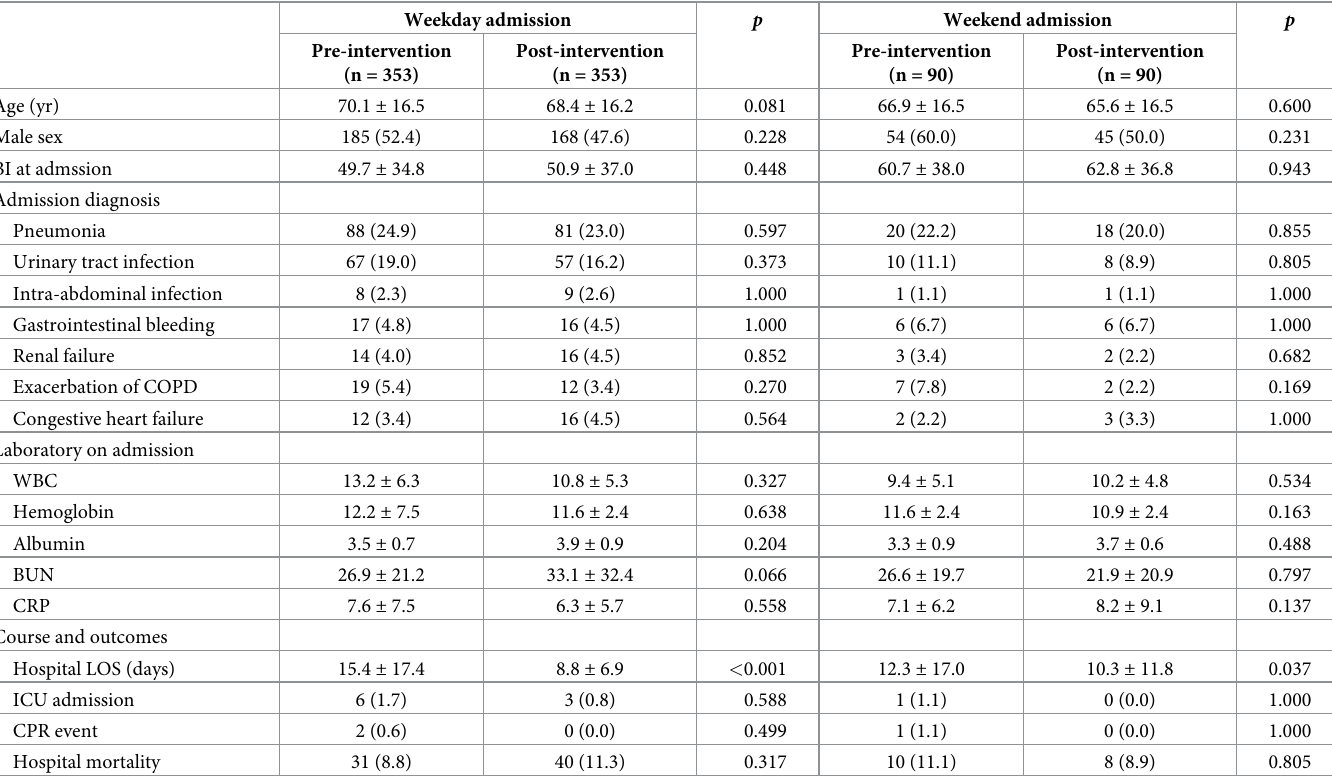
Table 3. Results of propensity score matching for care on weekday and weekend admissions between the pre- and post-intervention